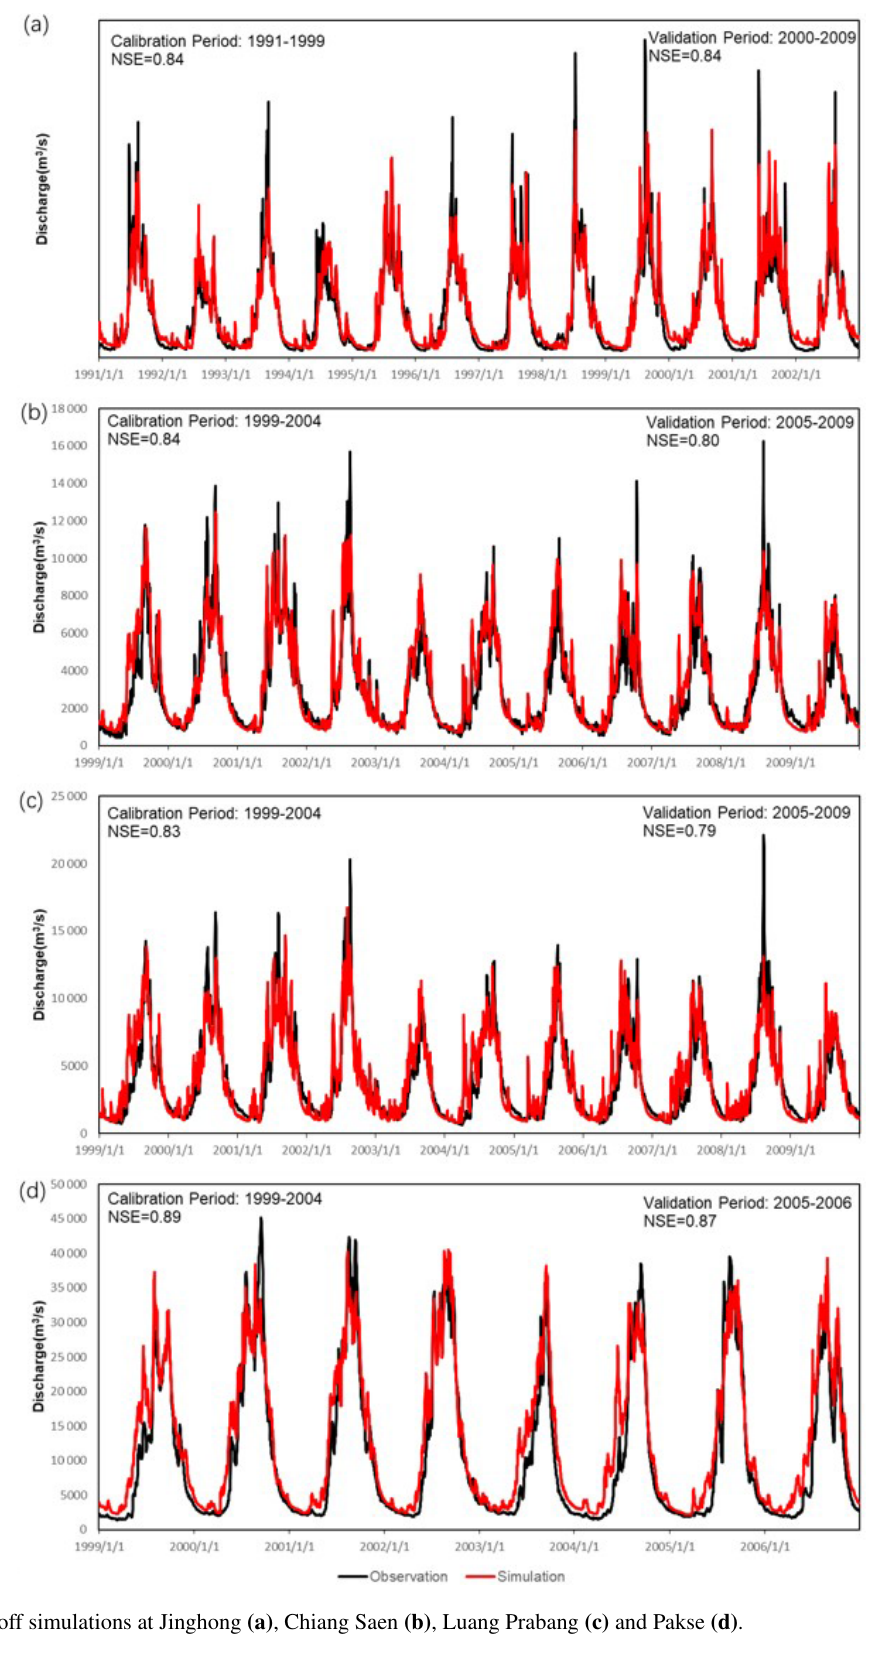
Figure 5. Daily Runoff simulations at Jinghong (a) , Chiang Saen (b) , Luang Prabang (c) and Pakse (d)